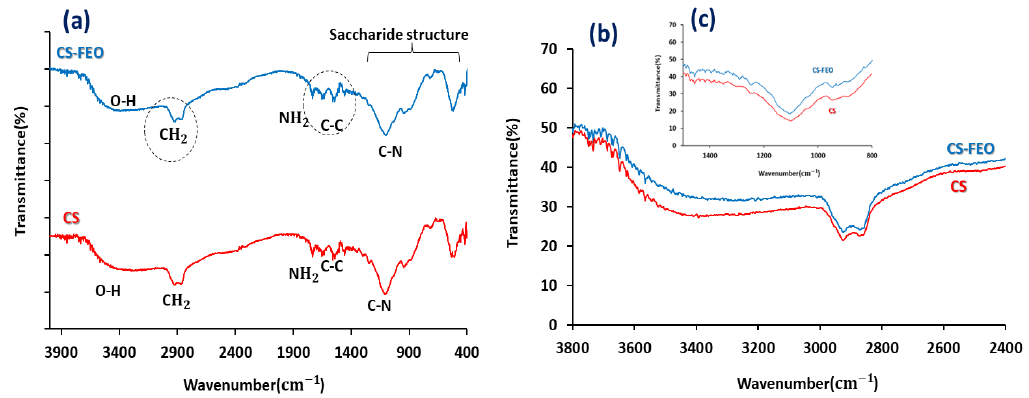
Fig. 3. (a-c) FTIR spectra of the pure CS and CS-FEO nanocomposite.